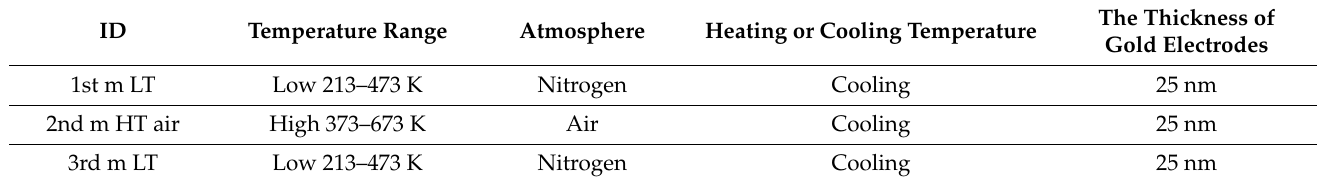
Table 1. The list of conditions used for the electrical measurements of the 5BeNa sample.